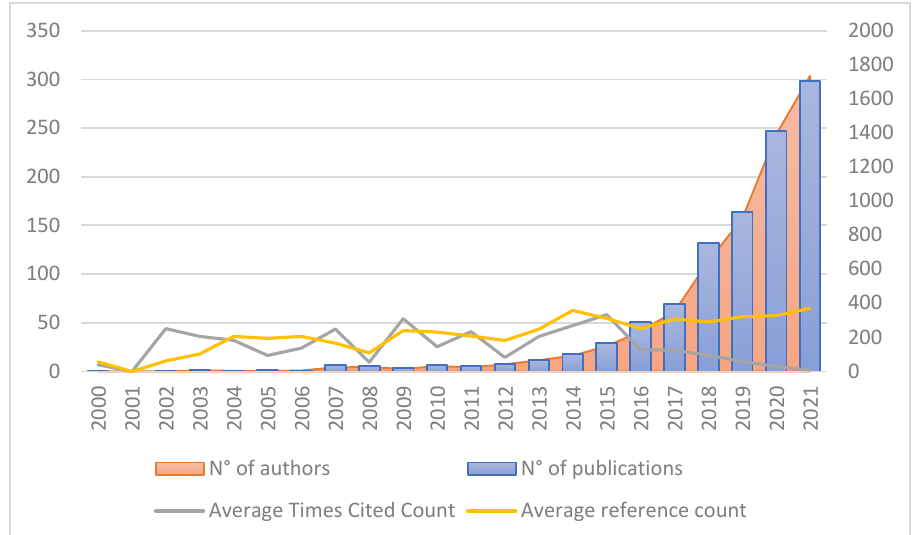
Figure 1. Number of authors and publications, average citations and the reference count of biostimulant publications between 2000 and 2021. Data for the first two months of 2022 are not represented in the figure. Table 1. Quantitative analysis of the trend of research on biostimulants.